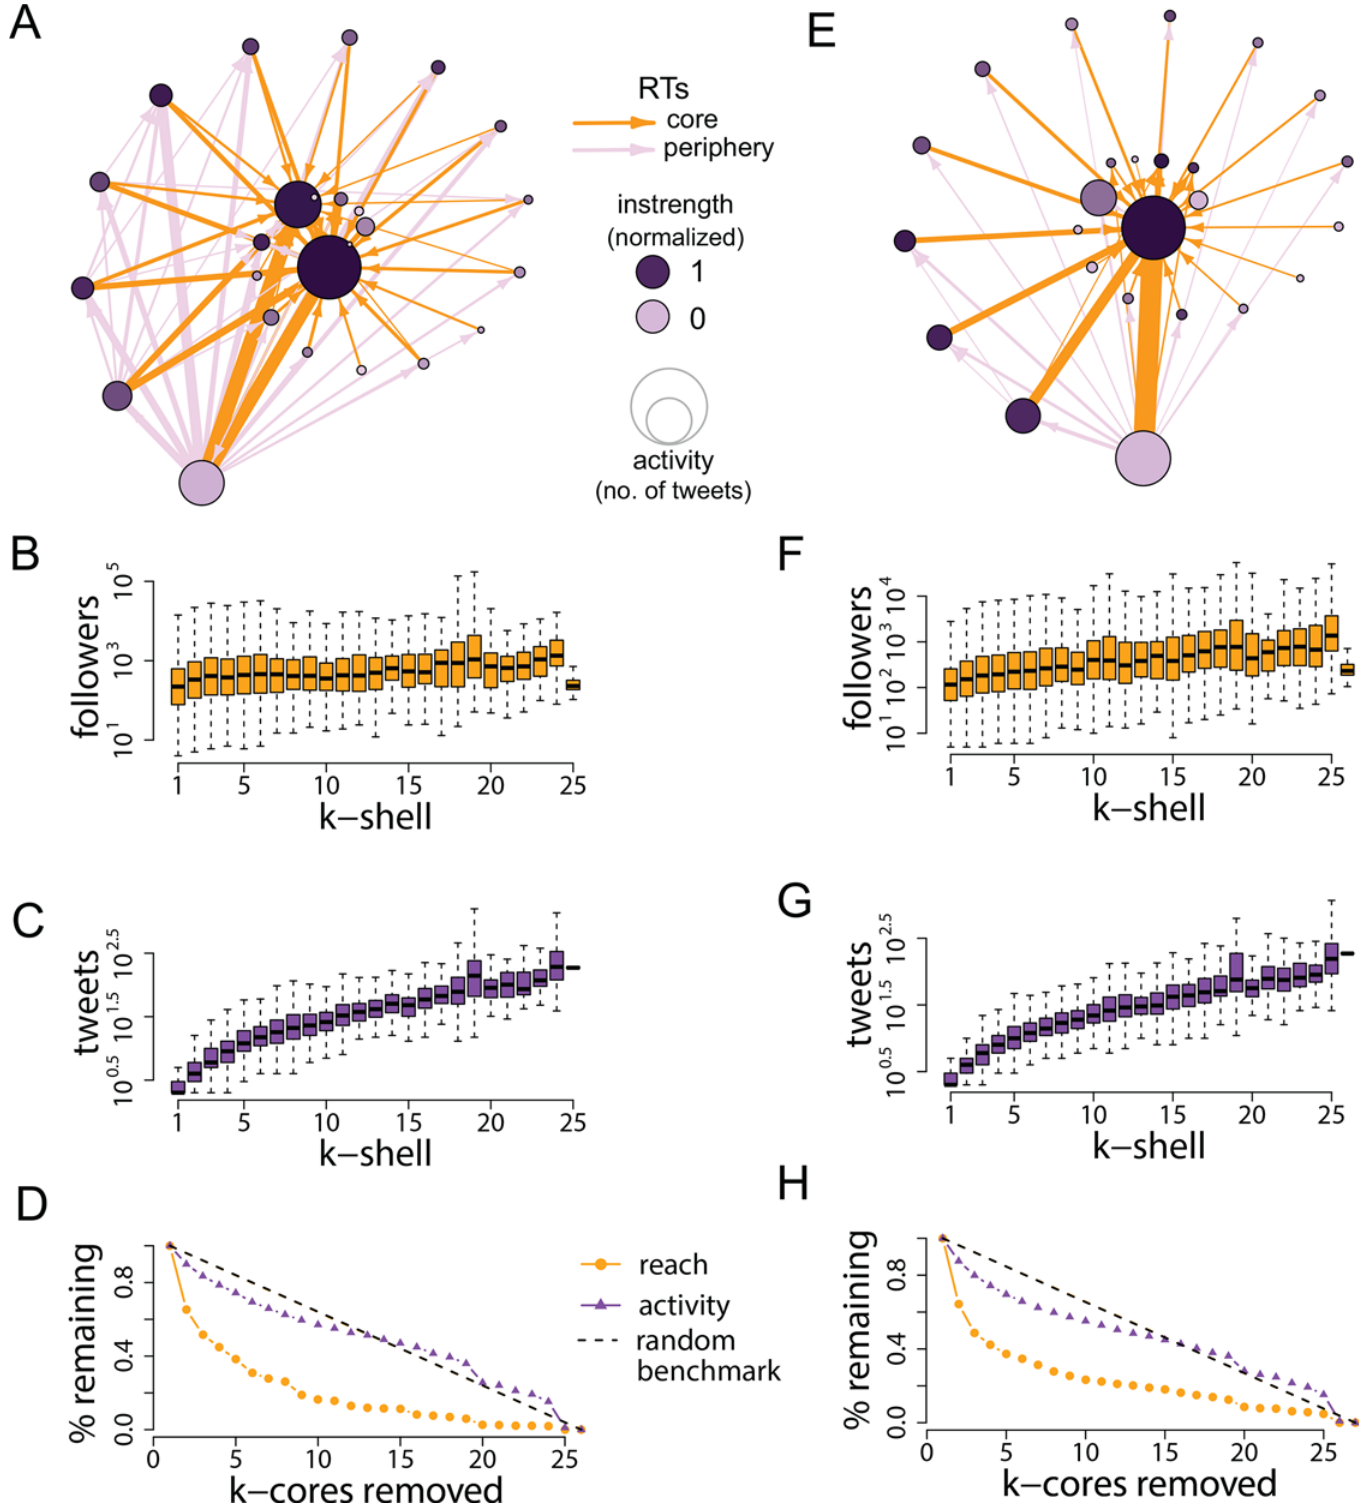
Fig 5. Core-periphery analysis for the Occupy and Indignados networks. Panels A and E visualize the connections across k -cores (arcs with lower strength have been filtered to improve visualization). Unlike the Turkish case, these protests did not have a clear epicenter, so nodes are colored in proportion to the number of retweets received (i.e. normalized instrength). Core-periphery dynamics are, however, similar to the Turkish case: most of